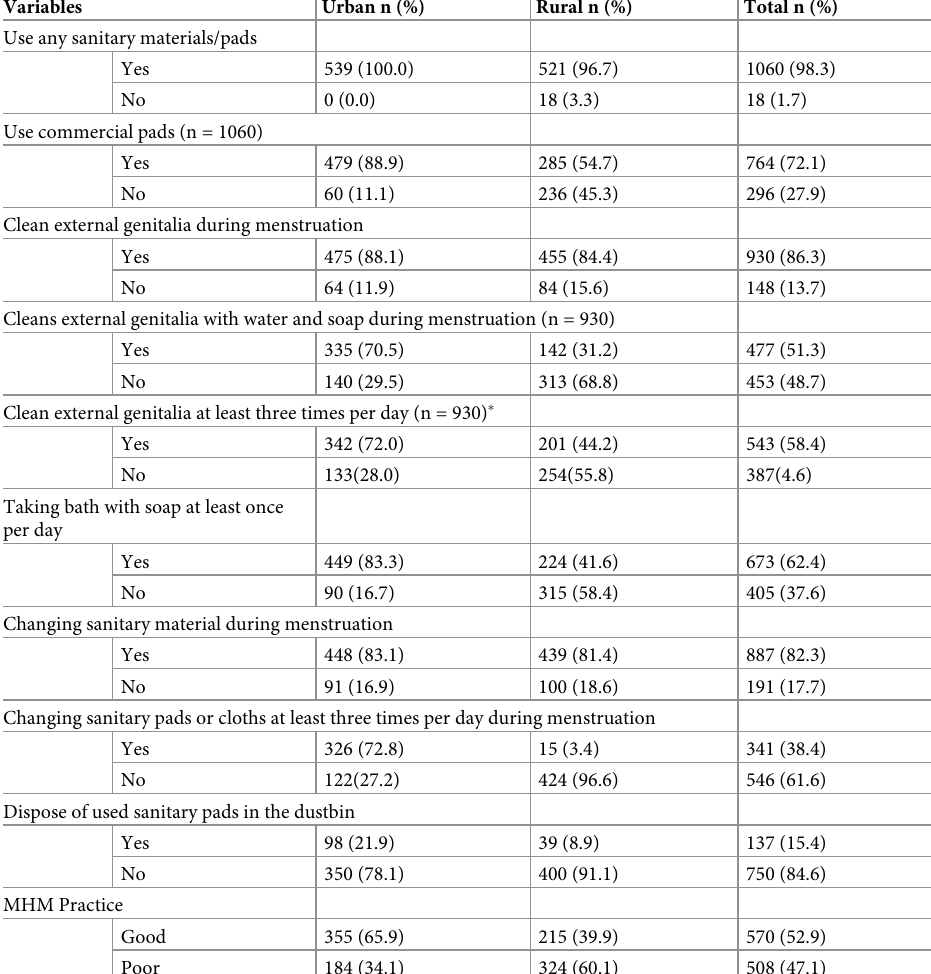
Table 3. Menstrual hygiene practice among urban and rural schoolgirls in Northeast, Ethiopia, 2020 (N = 1078; 539 urban and 539 rural).